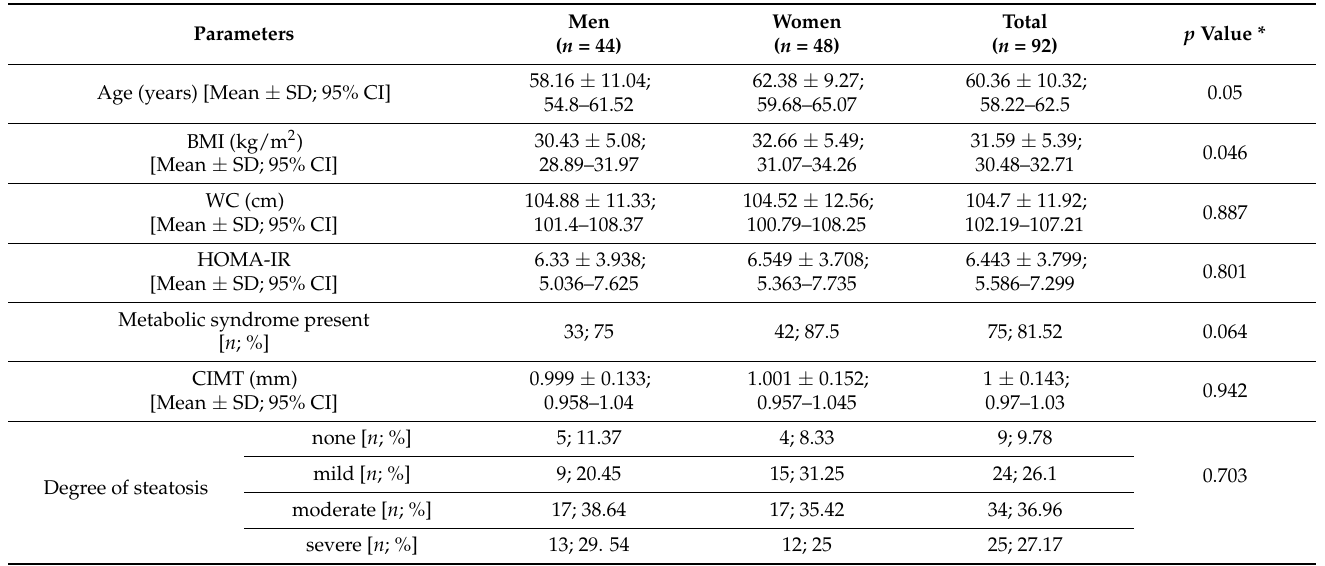
Table 1. General characteristics of the study